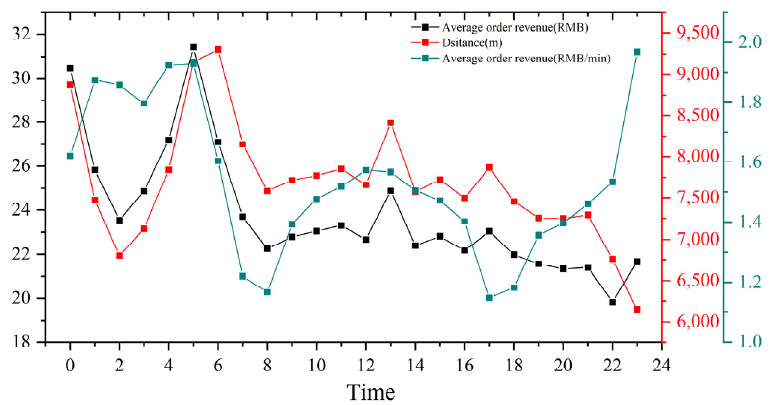
Figure 7. Order revenue and distance.